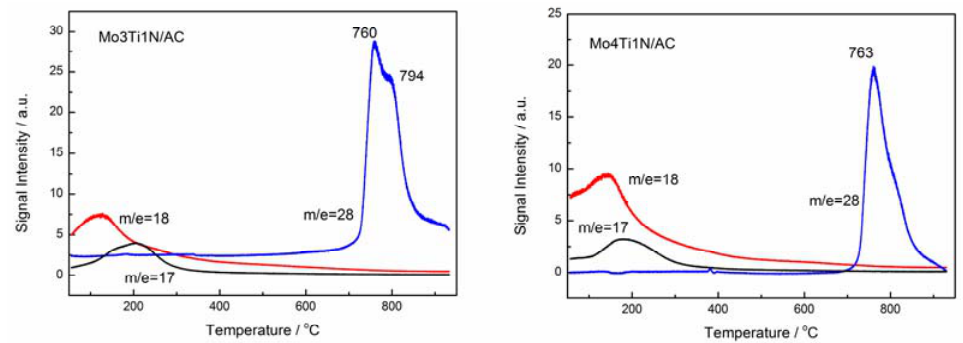
Figure 2. TPD ‐ MS profiles of six catalysts. Figure 2. TPD-MS profiles of six catalysts. Figure 2. TPD-MS profiles of six catalysts.